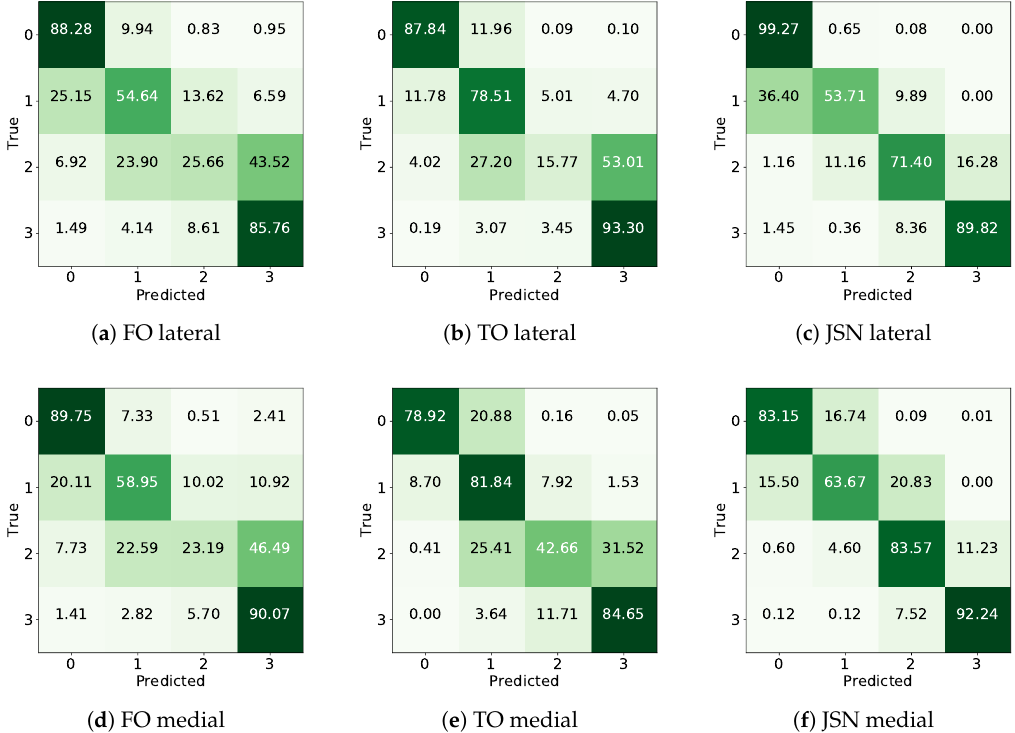
Figure 4. Confusion matrices for the OARSI grades prediction tasks: ( a – c ) the matrices for femoral osteophytes (FO), tibial osteophytes (TO) and joint space narrowing (JSN) automatic grading in lateral compartment, respectively; and ( d – f ) the confusion matrices in the same order, but for the lateral compartment. The numbers indicate